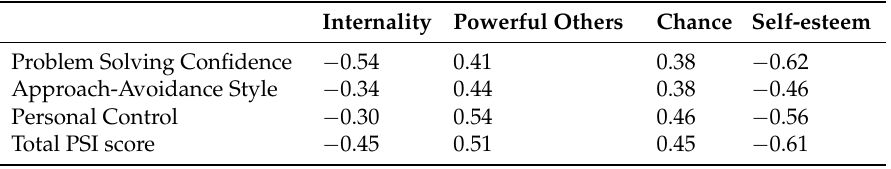
Table 3. Correlation coefficients of the Problem Solving Inventory subscales with IPC Locus of Control (LOC) Scale and the Rosenberg Self-Esteem Scale